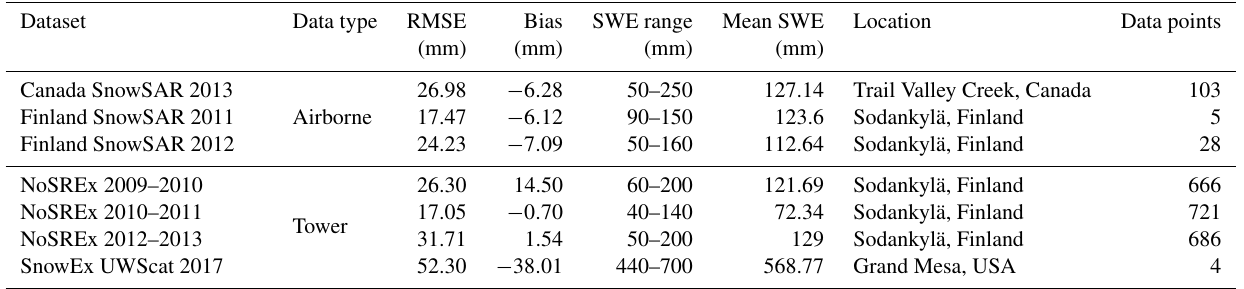
Figure 16. Three-dimensional plot of the σ 0 when plotted against two variables at Ku-band (black circles) along with a linear least-squares fits of σ 0 to two variables, SWE and single-scattering albedo (surfaces). The surface color indicates σ 0 value in decibels. Table 4. Summary of validations of the dual-frequency algorithm at 9.6 and 17.2GHz (Zhu et al., 2018, 2021a) against seven datasets of airborne and tower measurements. Details of the seven datasets are listed in Tables 2 and